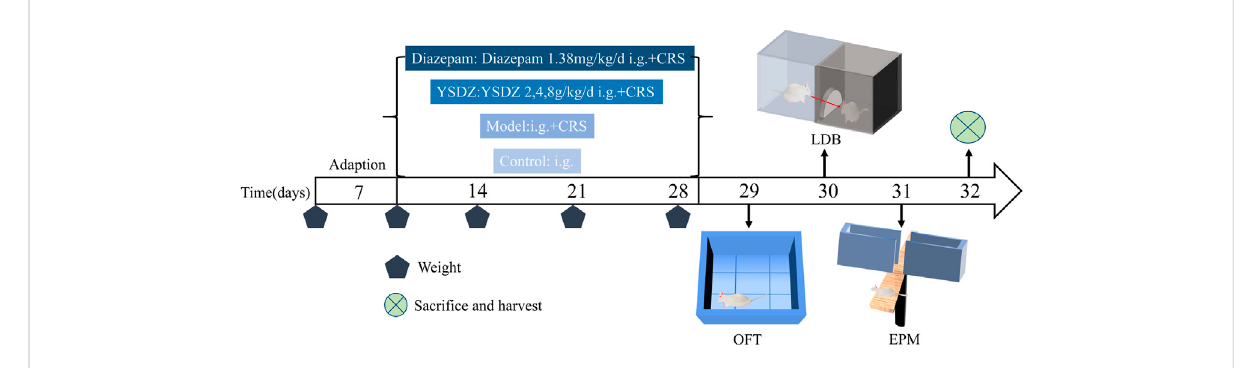
FIGURE 3 Experimental